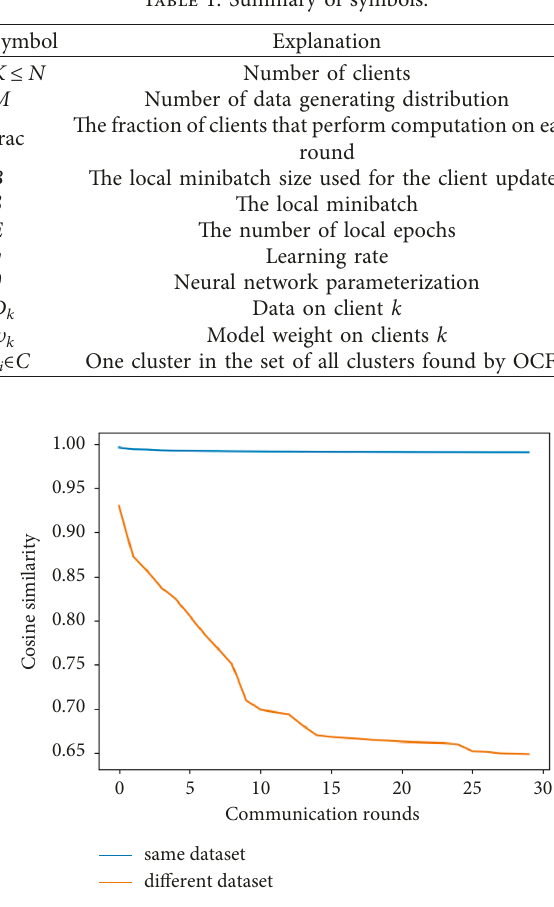
Figure 1: Cosine similarity result. The cosine similarity between model parameters from the same data set stays more or less constant throughout the FL process, the cosine similarity between model parameters from different data set quickly